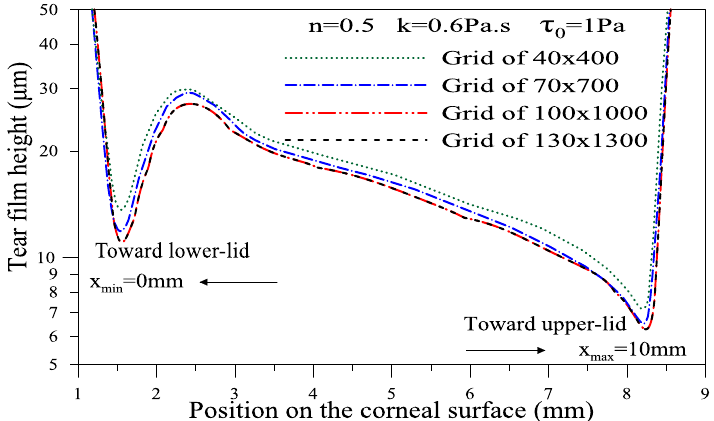
Figure 10. Evolution of film thickness for different mesh grids in the case of non-Newtonian film n = 0.5, k = 0.6 Pa·s and τ 0 = 1 Pa at t = 0.18 s.